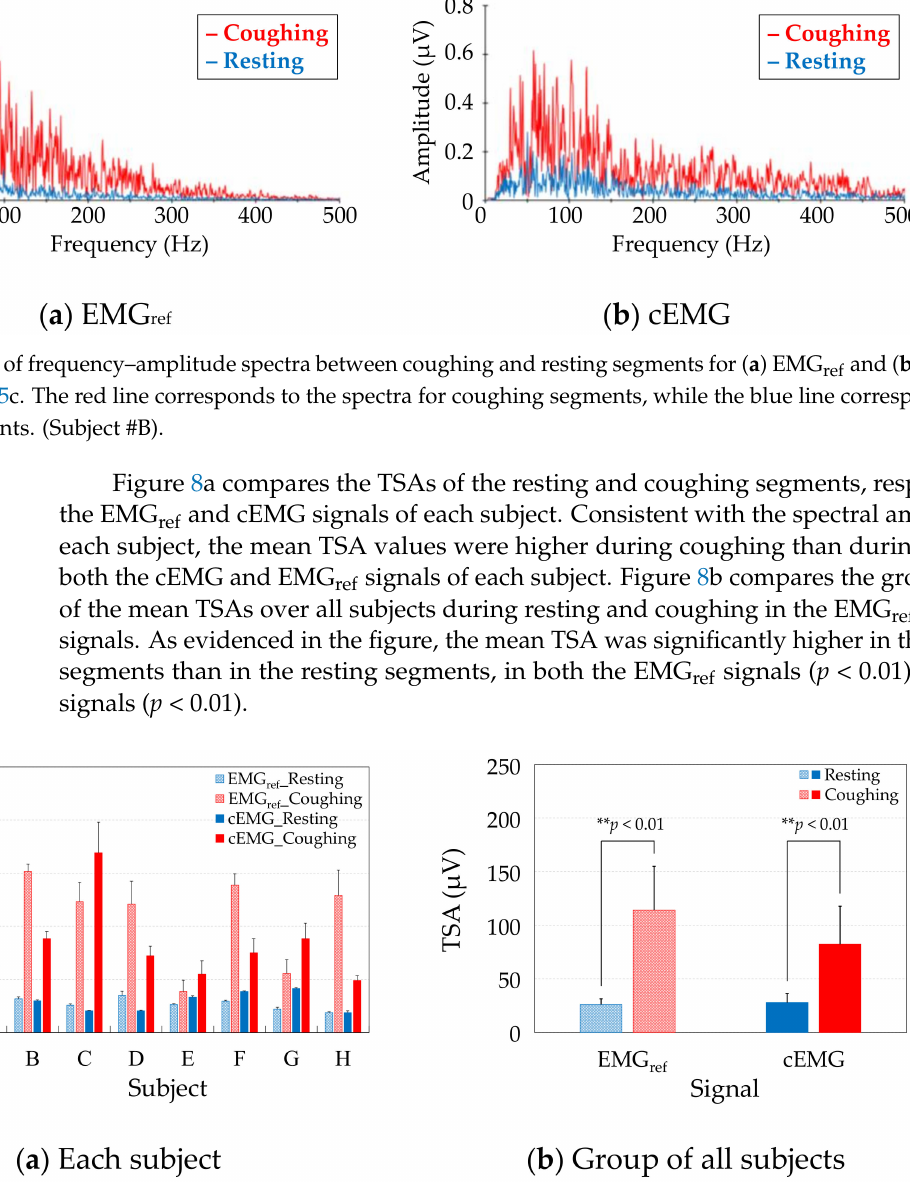
Figure 8. Comparison of mean total spectral amplitudes (TSAs) between resting and coughing in the EMG ref and cEMG signals of ( a ) each subject, and ( b ) the group of all